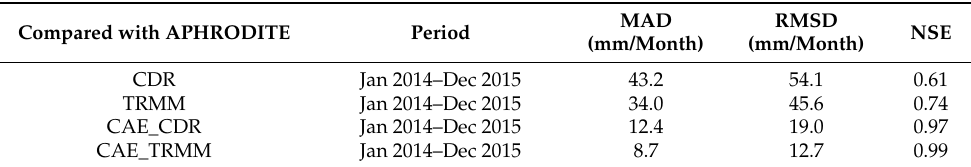
Table 2. Comparative correlation of average monthly rainfall between the precipitation products and APHRODITE